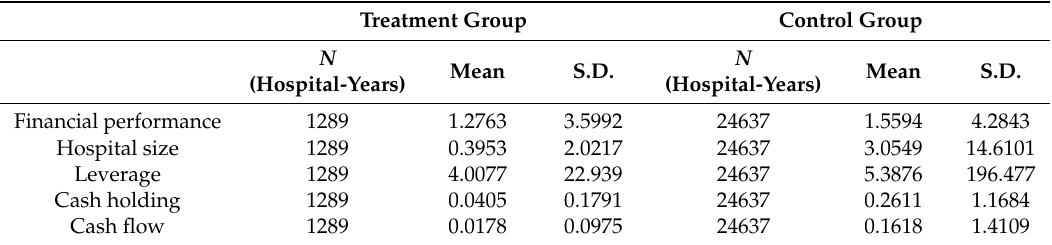
Table A1. An overview of variables (original sample).